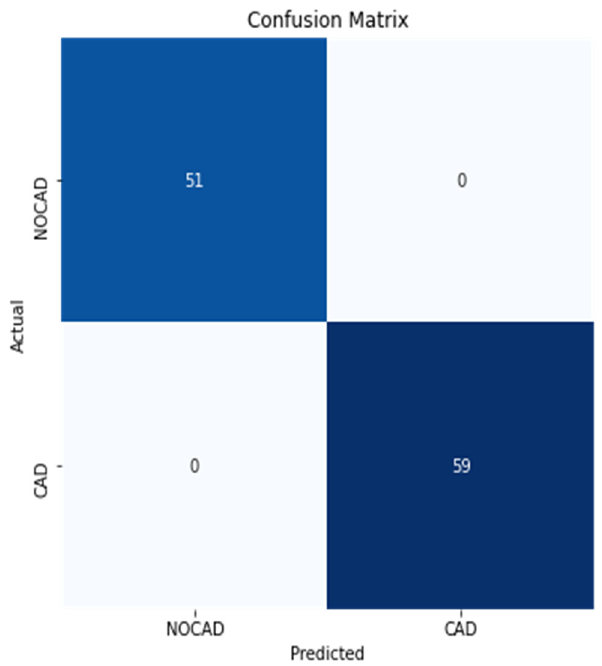
Figure 14. Confusion matrix for the 12-lead ECG.